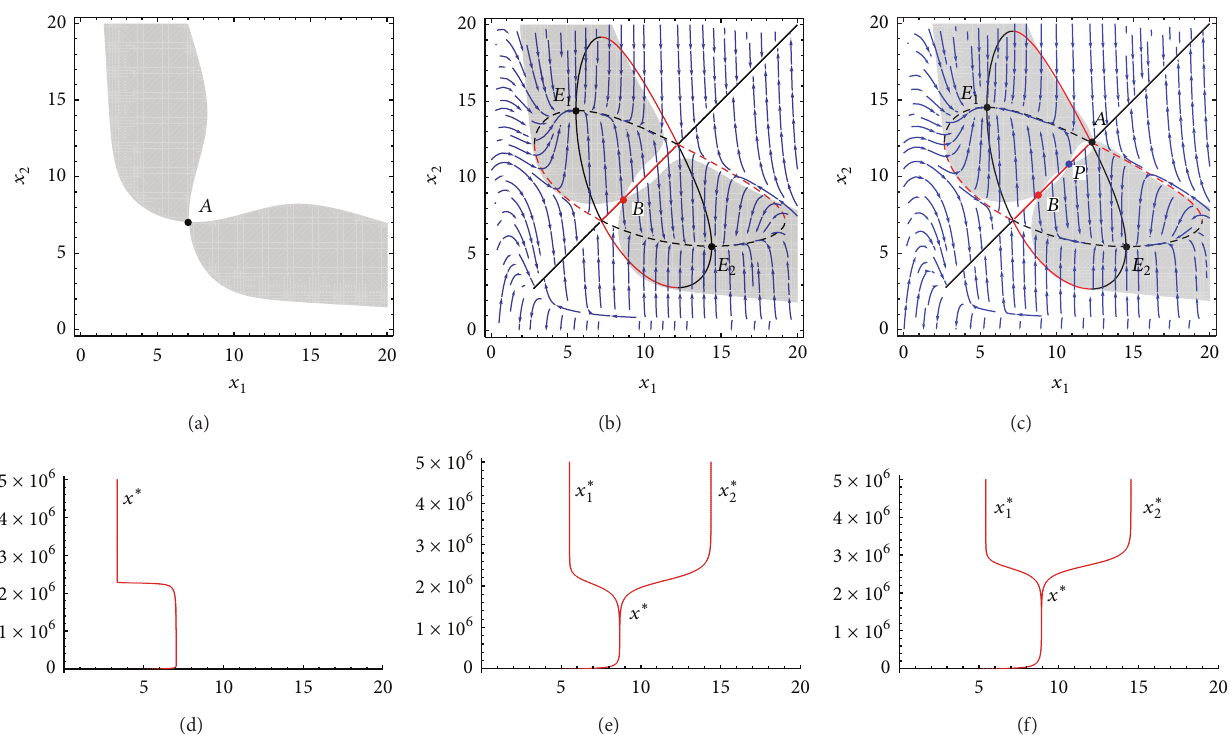
Figure 4: The coexistence plots are depicted, two strains are presented on separate axes and the gray areas define combinations of strains that are mutually invasible and the corresponding evolutionary branching. Shaded areas indicating protected dimorphism are separated by stable (black) and unstable (red) isoclines at which selection gradient vanishes in either 𝑥 1 -direction or 𝑥 2 -direction. Red bullet 𝐵 = initial branching point, black bullet 𝐴 = evolutionarily stable singularity, black bullet 𝐸 𝑖 ( 𝑥 ∗ 1 ,𝑥 ∗ 2 ) = stable singular coalition, and 𝑖 = 1, 2 . “ ∙ ” 𝑃 = repeller point. Correspondingly, below the coexistence plots we simulate evolutionary trees with branching patterns. (a) and (d) 𝑝 = 0.5 ; (b) and (e) 𝑝 = 6 ; (c) and (f) 𝑝 = 8 . Other parameter values are 𝑐 = 2 , V = 0.8 , 𝜆 = 10.25 , 𝑘 = 0.3